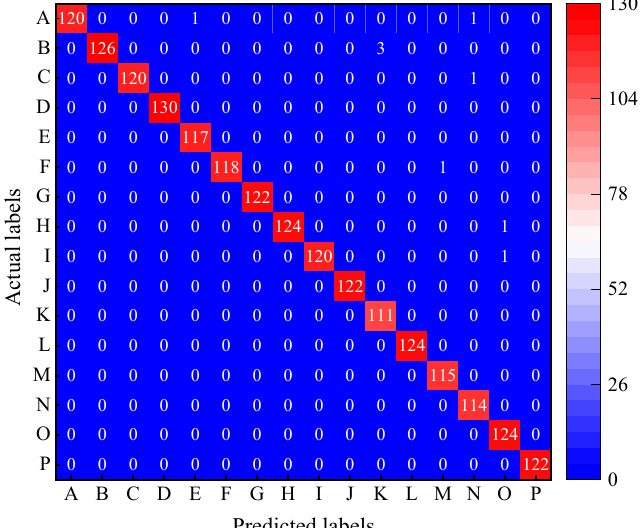
Figure 10. Confusion matrix. Table 5. Precision, recall and specificity.